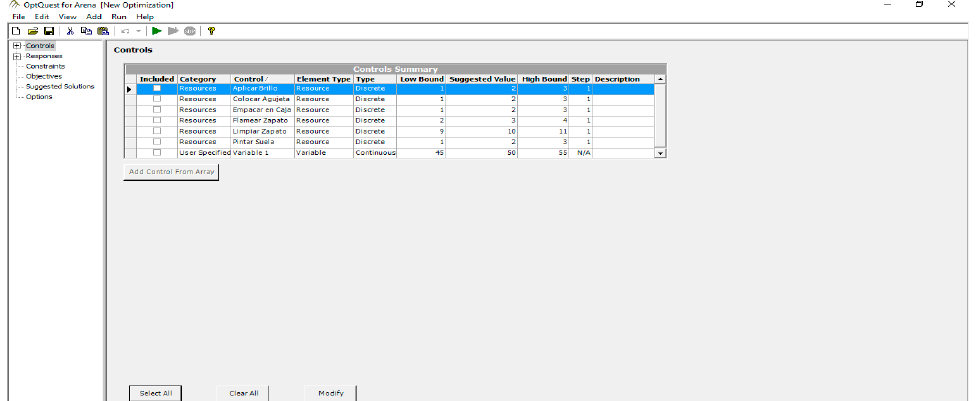
Figure A7. Selection of resources, restrictions, and objective function. Figure A7 . Selection of resources, restrictions, and objective function.